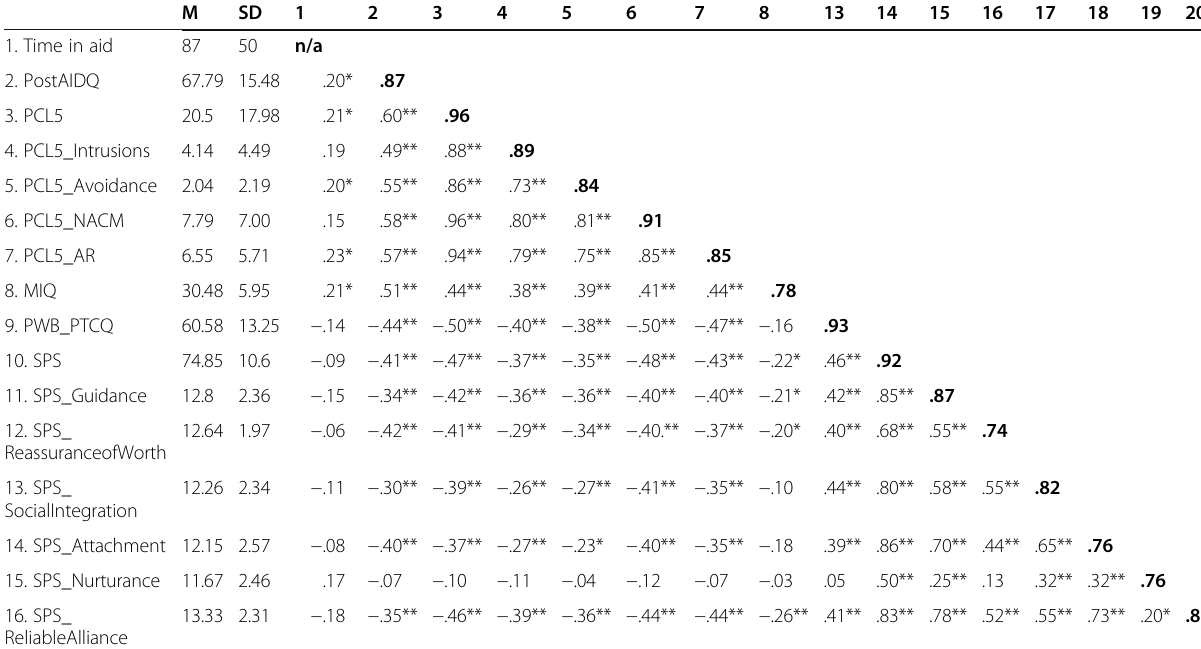
Table 3 Descriptive statistics, internal reliability and correlations between study variables including all subscales